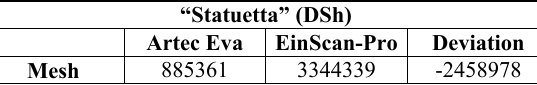
Table 6. DSh analysis of the “Olla” model